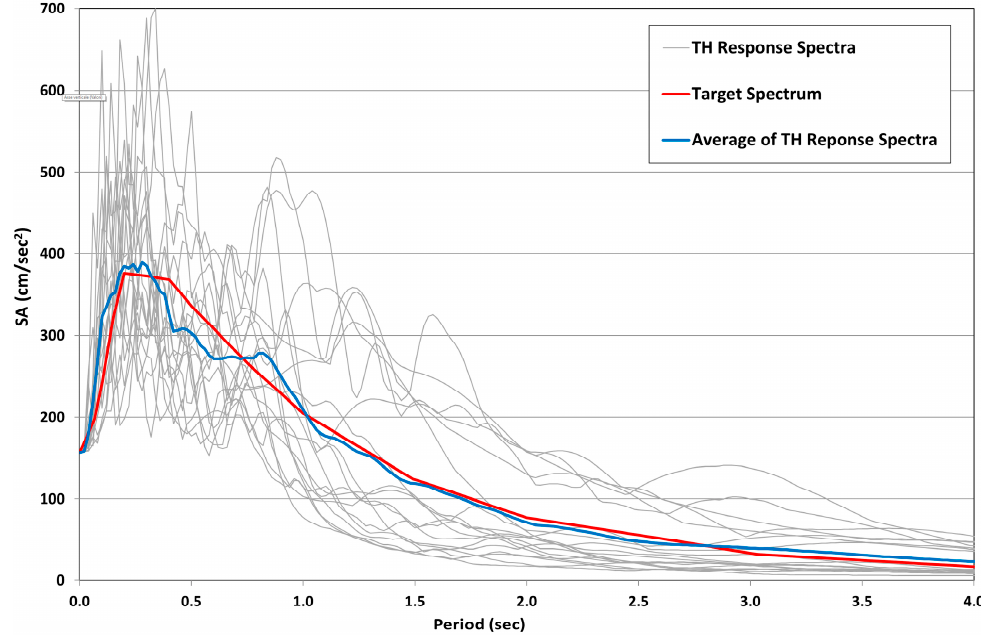
Figure 11. Response spectra of the selected input (grey) in comparison with the average response spectrum (blue) and target response spectrum (red).